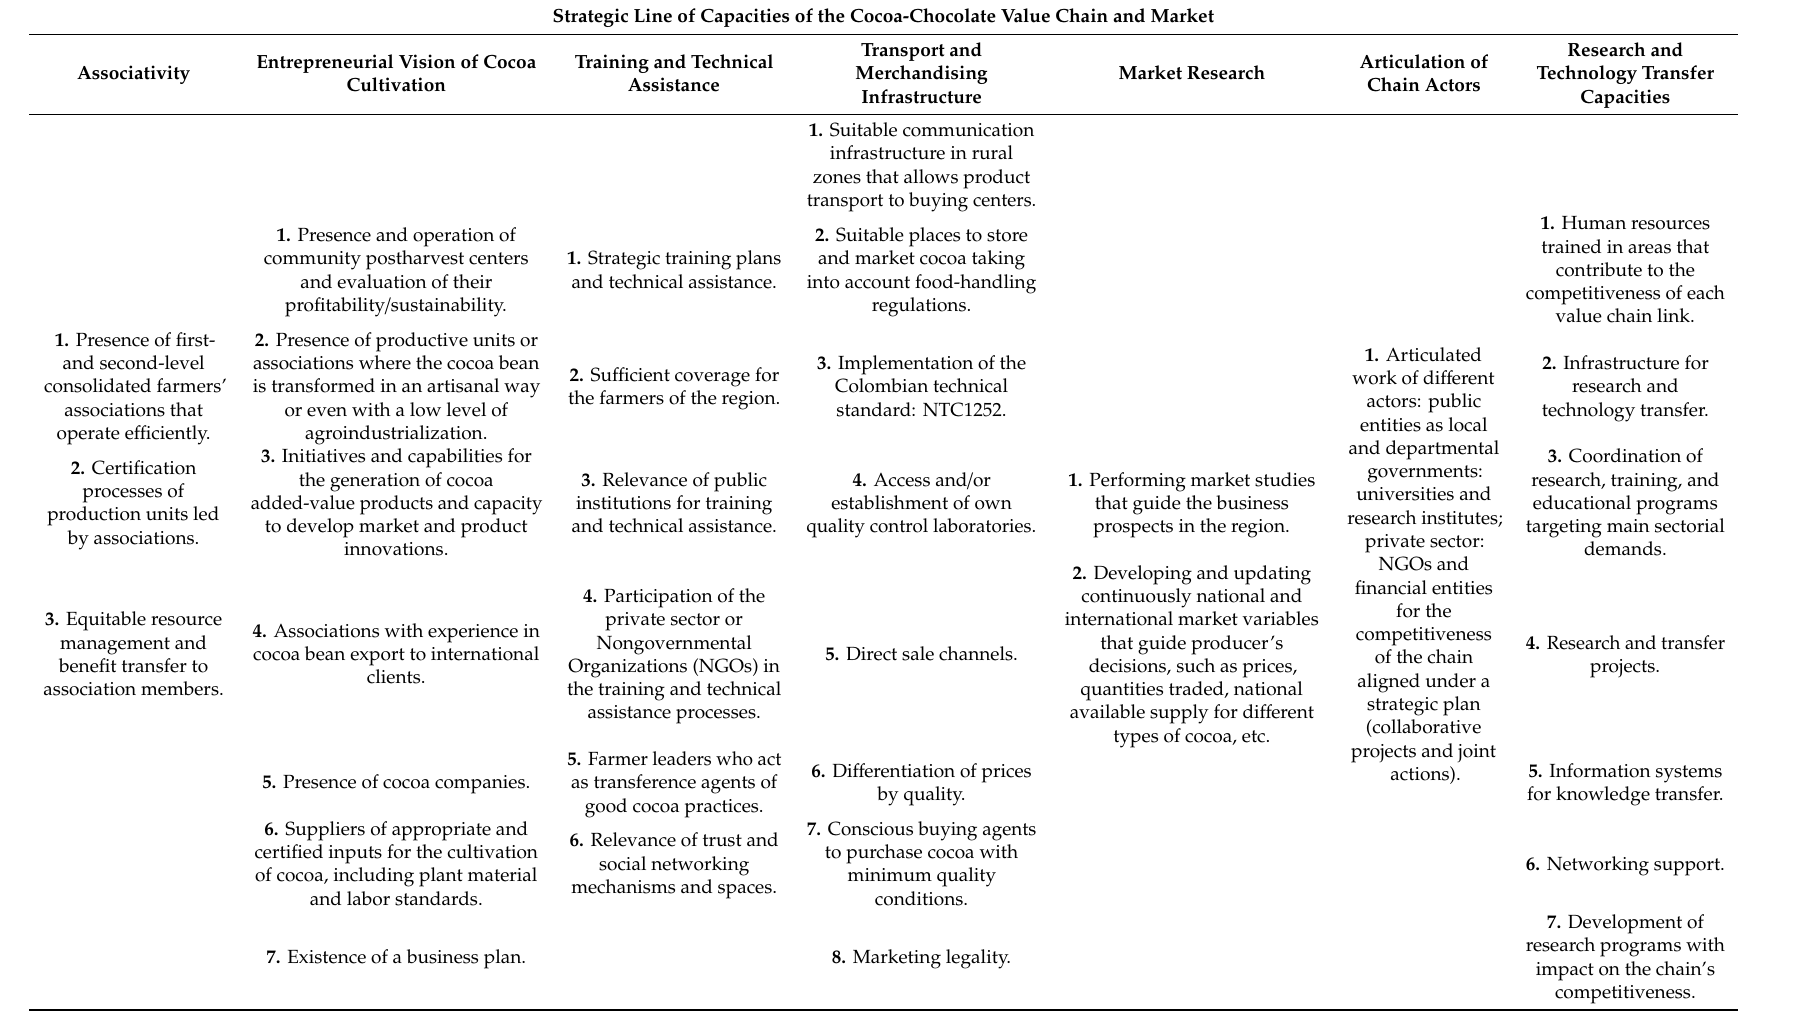
Table 4. Ideal practices / scenarios in the strategic line of capacities of the cocoa-chocolate chain and